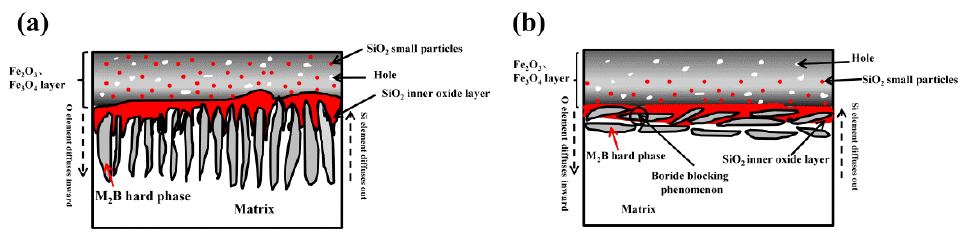
Figure 14. Schematic diagrams of high-temperature oxidation mechanisms: ( a ) Fe 2 B // A4 sample, ( b ) Fe 2 B ⊥ A4 sample. ( b ) Fe 2 B ⊥ A4